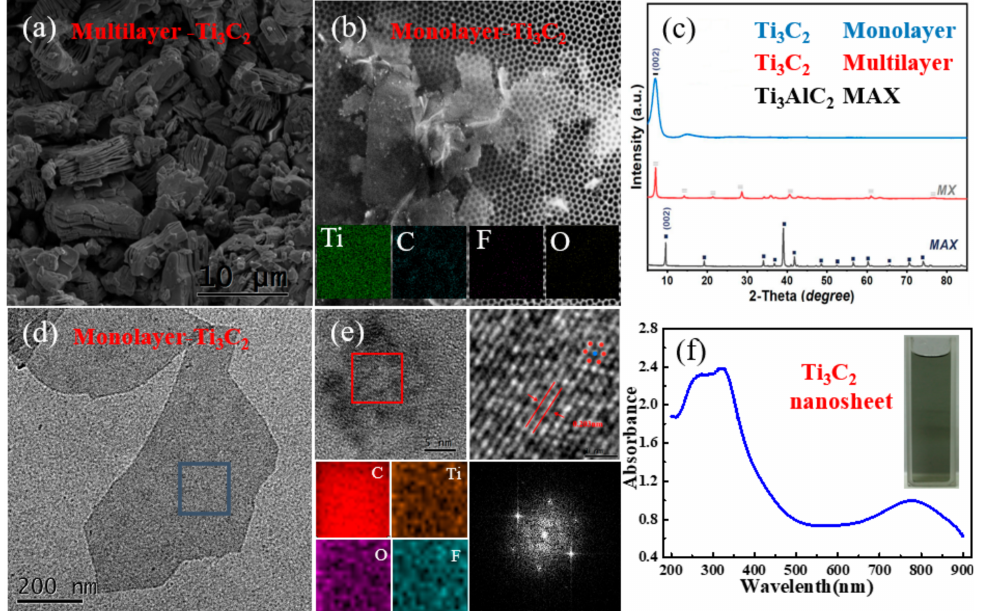
Figure 1. ( a , b ) Scanning electron microscopy (SEM) images of multilayer and monolayer Ti 3 C 2 nanosheets; ( c ) X-ray di ff raction patterns of MAX phase Ti 3 AlC 2 (black), monolayer Ti 3 C 2 (red), and multilayer Ti 3 C 2 nanosheets (blue); and ( d ) transmission electron microscopy (TEM) image of a monolayer Ti 3 C 2 nanosheet. ( e ) The top panels show a high-resolution TEM image and schematic illustration of the atomically resolved image with an overlaid schematic atomic structure, and the bottom panels present STEM-energy-dispersive X-ray (EDX) mapping and Fast Fourier Transform (FFT) of the Ti 3 C 2 original image. ( f ) Linear absorption spectra of the Ti 3 C 2 nanosheet, where the inset is a picture of the aqueous solution of the Ti 3 C 2